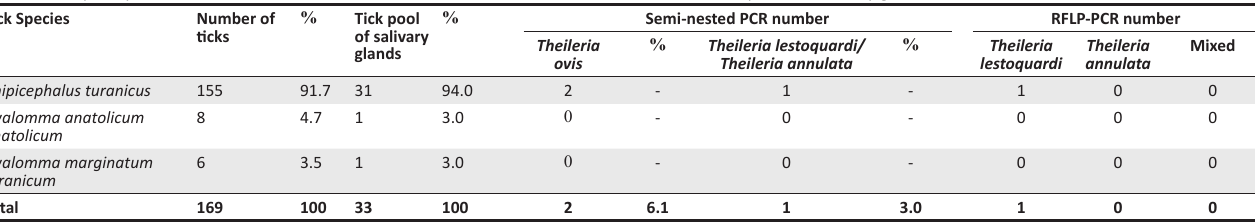
TABLE 4: Frequency of tick infestation with the results of molecular methods for detection Theileria species in salivary glands of Ixodid ticks. Tick Species Number of